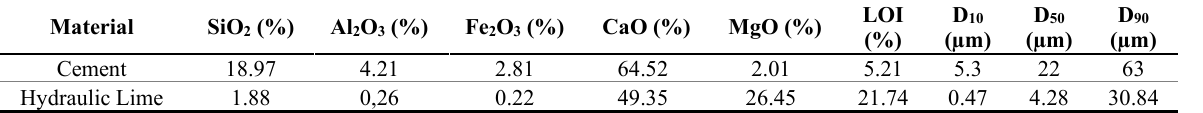
Table 1. Chemical and Physical characteristics of cement and hydraulic lime